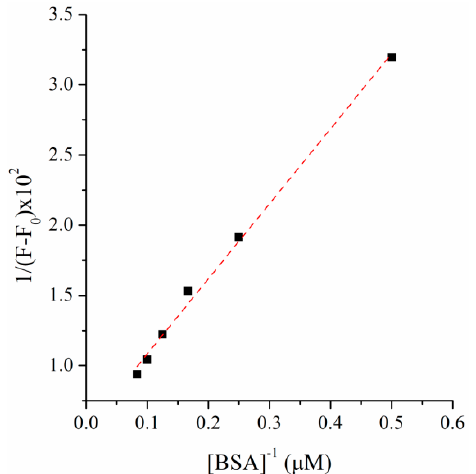
Figure 7 . Benesi–Hildebrand fluorescence plot for 1:1 complexation of compound 12 with BSA ( R 2 = 0.994).